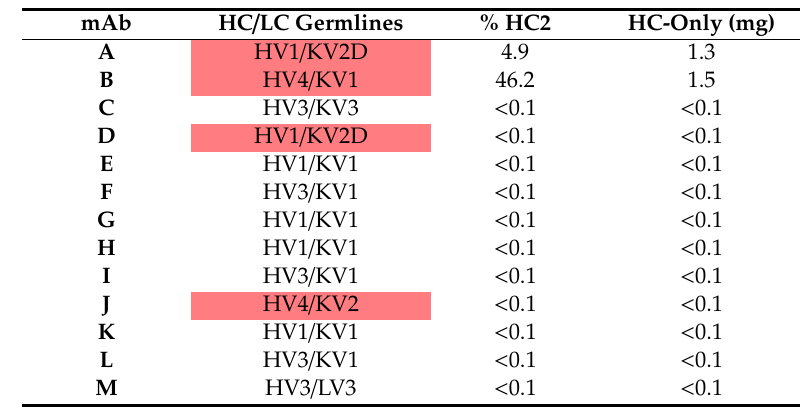
Table 2. For a panel of 13 recombinant antibodies, tabulated are the HC / LC germlines. These are highlighted red if considered uncommon ( < 10 occurrences) and unhighlighted if common ( > 20 occurrences out of 358 kappa-LC containing sequences) [25]. Also tabulated are the % HC dimer (HC2) quantified by NR-cSDS from HC / LC cotransfection (mAb production) and the amount in mg of HC2 species obtained from HC-only small-scale transfection (10 mL total